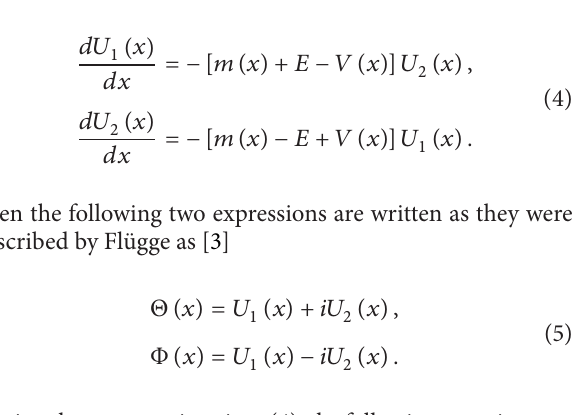
̃𝐿 = 2 (solid lines) and 𝑉 0 = 1 , 𝑝 = 1 , ̃𝑝 = 1 , 𝑞 = 1 , ̃𝑞 = 1 , 𝐿 = 2 , and ̃𝐿 = 2 (solid lines) and 0